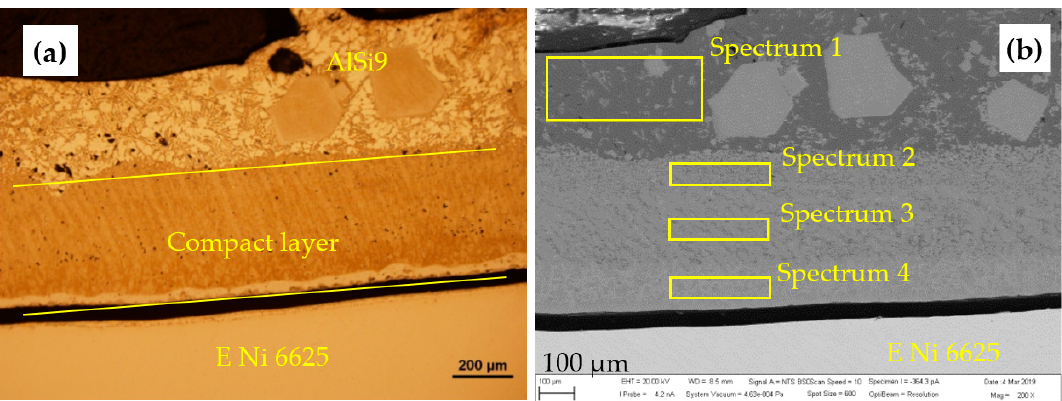
Figure 14. E Ni 6625/680 °C/300 min/AlSi9. Intermetallic compounds at the boundary between the E Ni